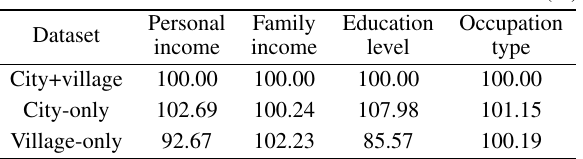
Table 5 Change ratio of F1-measure of people living in city or